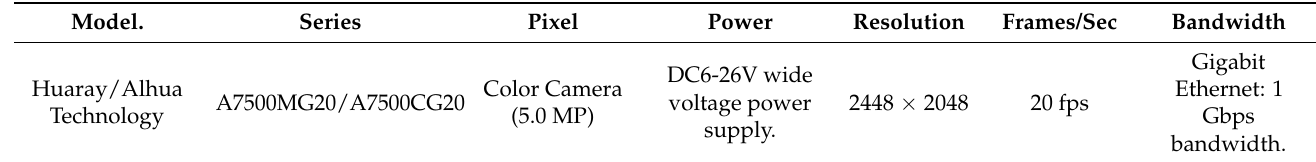
Table 3. Industrial Camera Configuration.